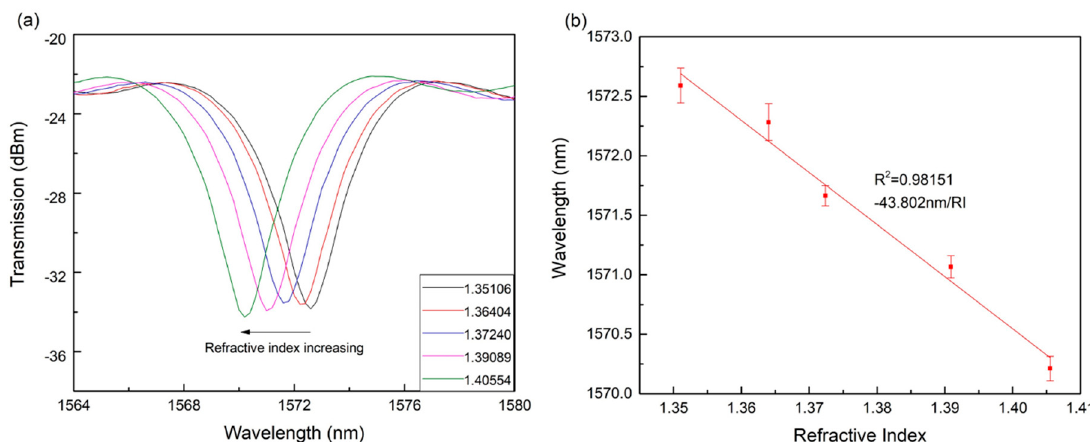
Figure 7. The transmission spectrum and the fitting curve of glycerol aqueous solutions. ( a ) Transmission spectrum of the long-period grating (LPG) optical fiber sensor in different refractive index glycerol aqueous solutions. ( b ) Fitting curve of the wavelength shift of peak and the change value of refractive index.